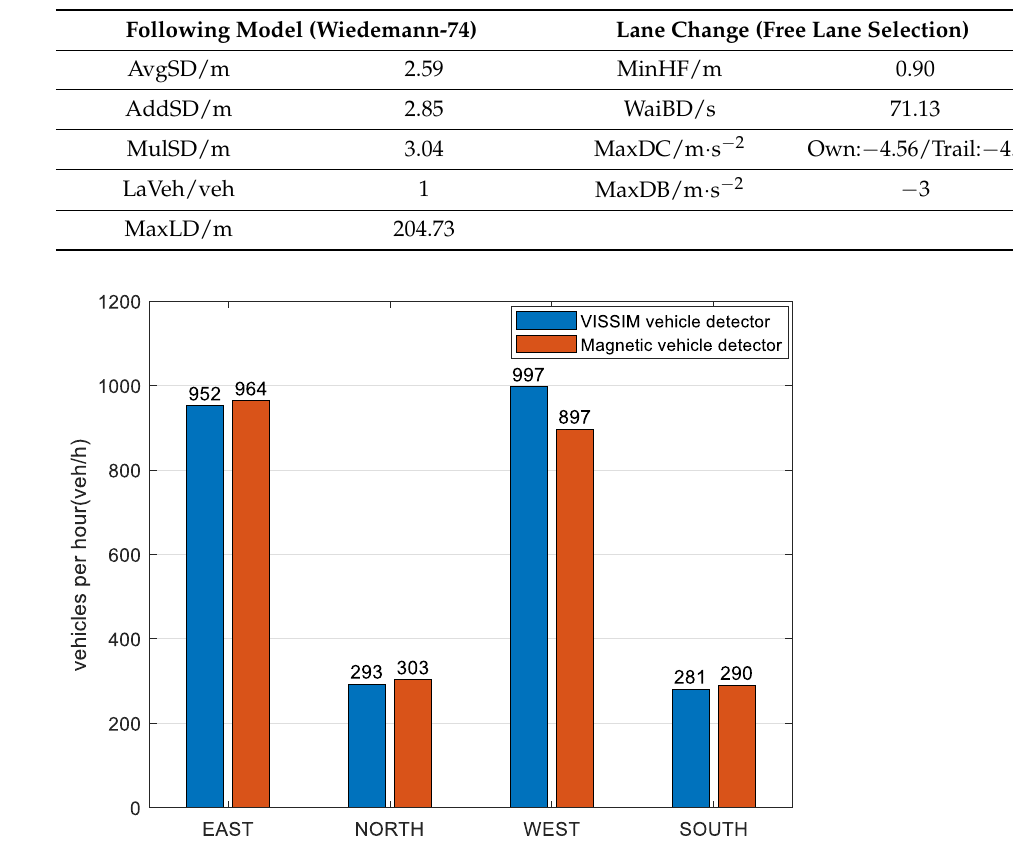
Figure 3. The VISSIM detection data and the magnetic detector data after calibration. Table 5. The calibration parameters of VISSIM.